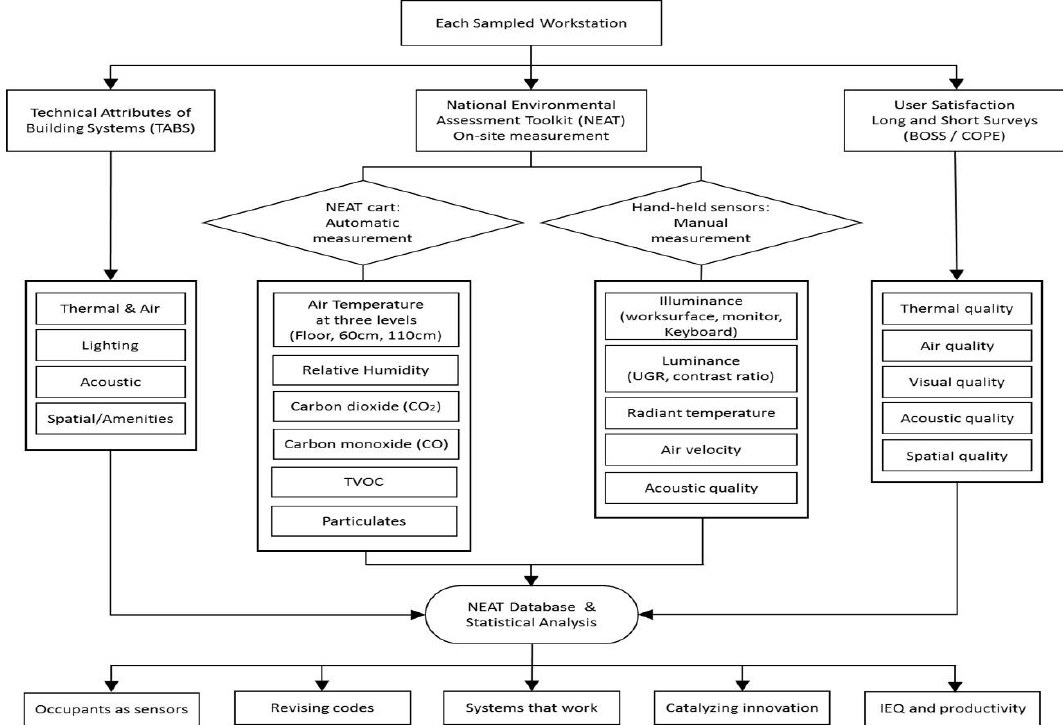
Figure 1. Carnegie Mellon University’s (CMU’s) 3 datasets: Building systems survey, indoor environmental quality (IEQ) field measurements, and user satisfaction survey.